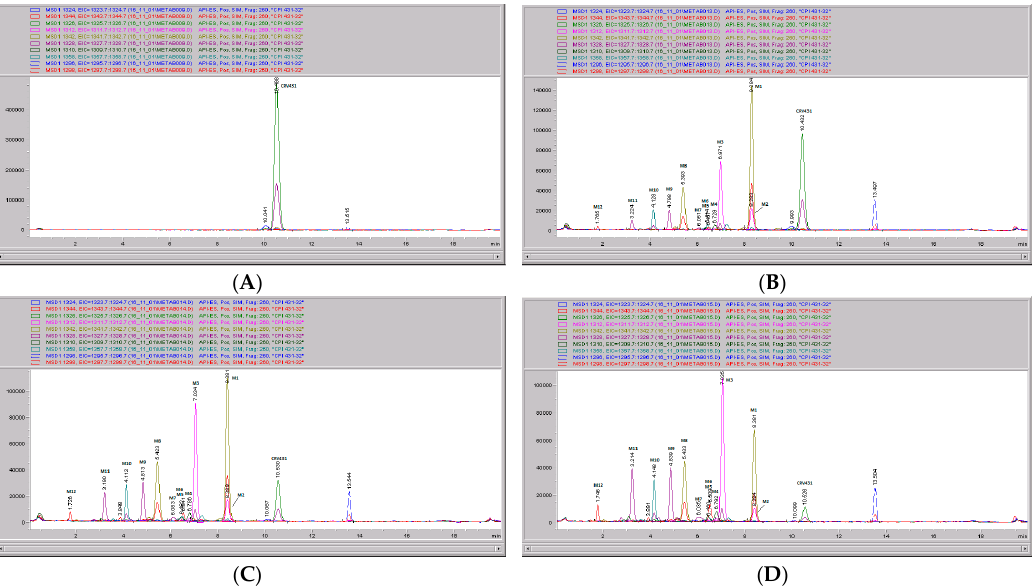
Figure 7. CRV431 metabolism in human liver microsomes. Human liver microsomes (1 mg/mL) were incubated with 1 ug/mL CRV431, and extracts were removed at 0 (panel A ), 20 min (panel B ), 40 min (panel C ), and 80 min (panel D ) for analysis by ESI-LCMS. Each liquid chromatography—mass spectrometry (LC–MS) profile displays the metabolite abundances as a function of chromatographic retention time. Table 4. Identification of CRV431 metabolites in human liver microsomes. Human liver microsomes (1 mg/mL) were incubated with 1 ug/mL CRV431, and extracts were removed for analysis by ESI-LCMS. Component